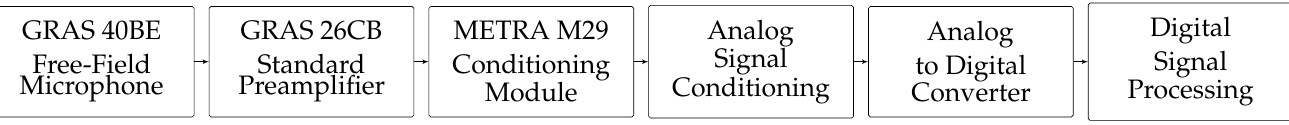
Figure 1. Block diagram of the HiFUsPEx